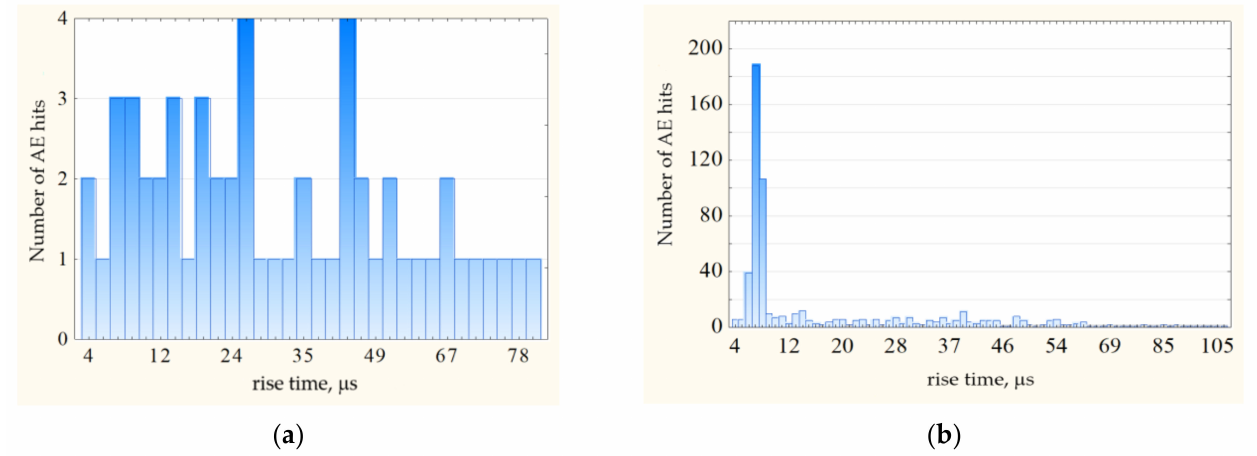
Figure 11. Frequency histogram of AE hits’ rise times for defect-free welded joint ( a ) and for welded joint with diffusion interlayers ( b ).